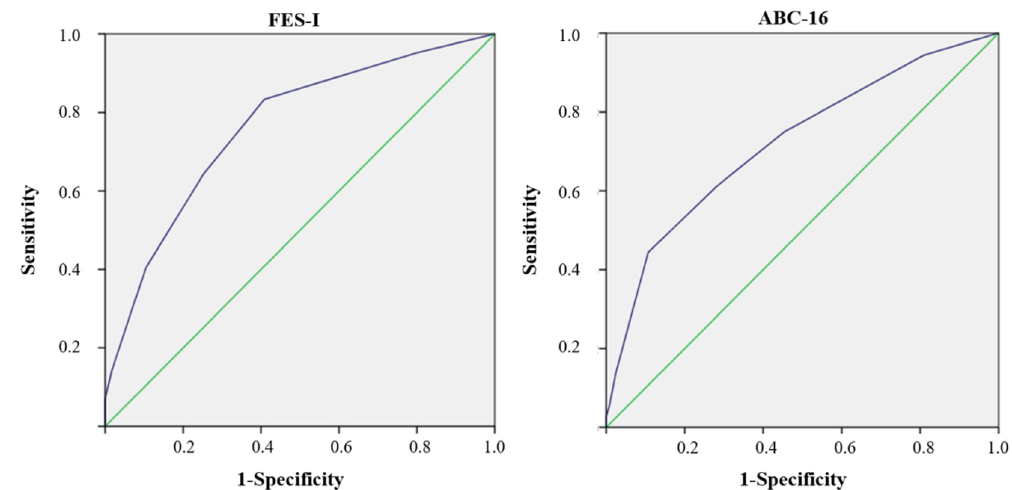
Figure 2. The ROC curves of FES-I and ABC-16. 1-Specificity: false-positive rate. ABC-16: Activities-Specific Balance Confidence scale-16 items. FES-I: Falls-Efficacy Scale-International. ROC: receiver-operating characteristic. The blue line represents the ROC curve and the green line is the reference line.